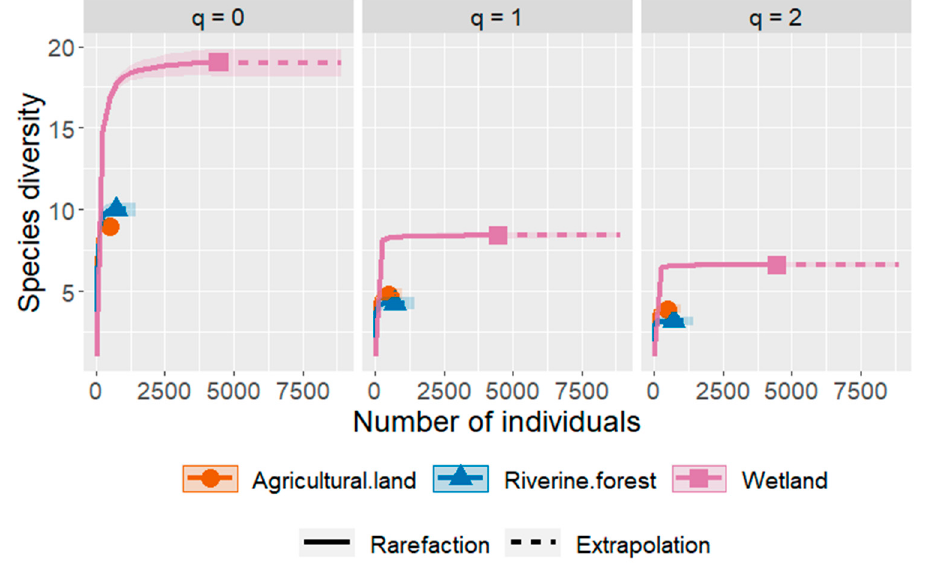
Figure 8. Comparison of the diversity of anuran species in three habitat types in the Keffa area through rarefaction solid lines and extrapolation dotted lines based on the number of individuals of the frog species. Species diversity was estimated using Hill numbers: q = 0 (frog species richness), q = 1 (exponential of Shannon’s entropy index) and q = 2 (inverse of Simpson’s concentration index).